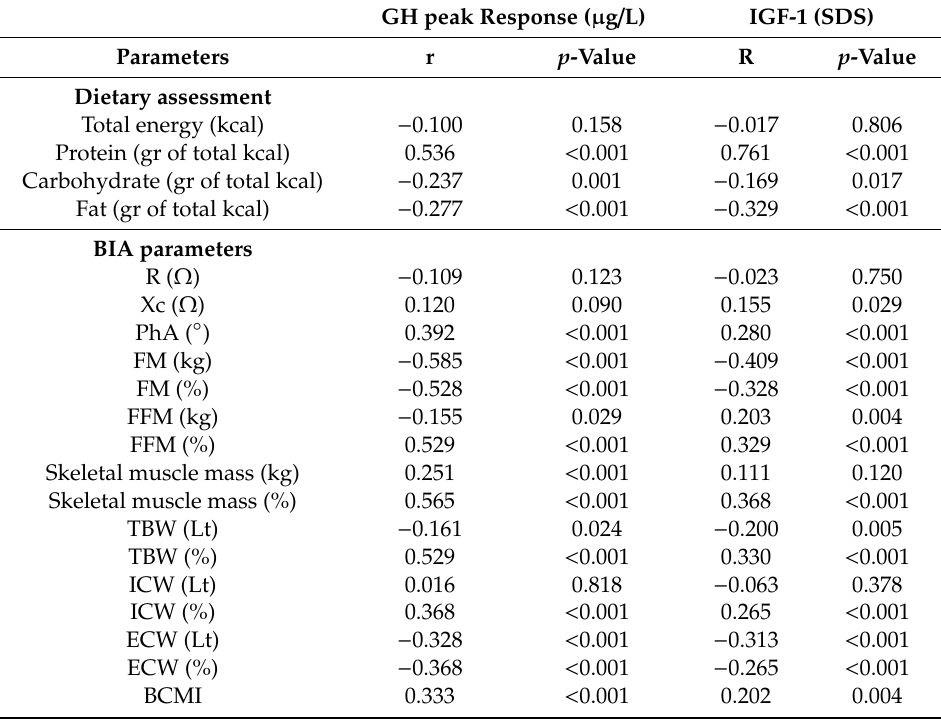
Table 6. Correlation between GH peak response and IGF-1 SDS with nutrient intake and BIA